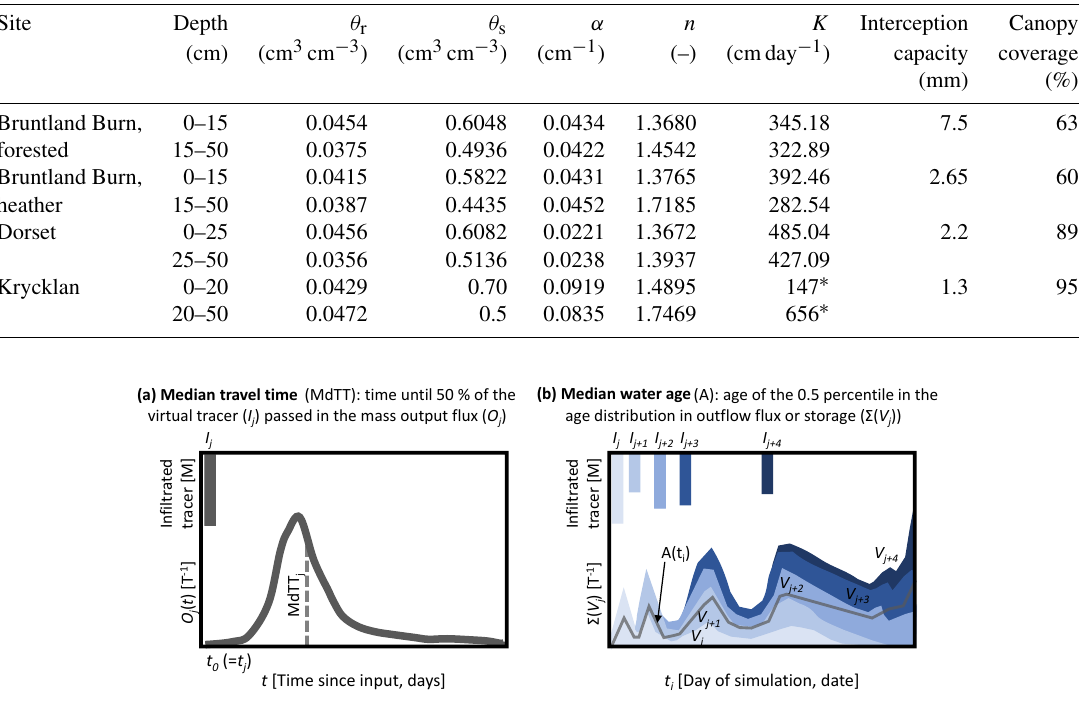
Figure 1. Conceptual visualization of the procedure used to derive median travel times (MdTT) of output fluxes (i.e. evaporation, transpira- tion, recharge) (a) and median water ages ( A ) in the output fluxes or the soil storage (total storage, storage in fast and slow flow domains, respectively) (b) . For MdTT, the breakthrough of an infiltrated virtual tracer mass ( I j ) introduced for each individual day of rainfall/snowmelt was tracked in each tracer mass output flux ( O j (t)) . The median of the normalized outflow mass flux describes the time until half of the total tracer mass leaving the soil via the output flux was reached. The median water ages in fluxes and storage (visualized as the grey line) were derived from the age of the 50th percentile of the cumulative age distribution of individual tracer inputs (e.g. I j to I j + 4 ) contributing varying volumes ( V j to V j + 4 ) to the considered flux or storage, visualized with different blue